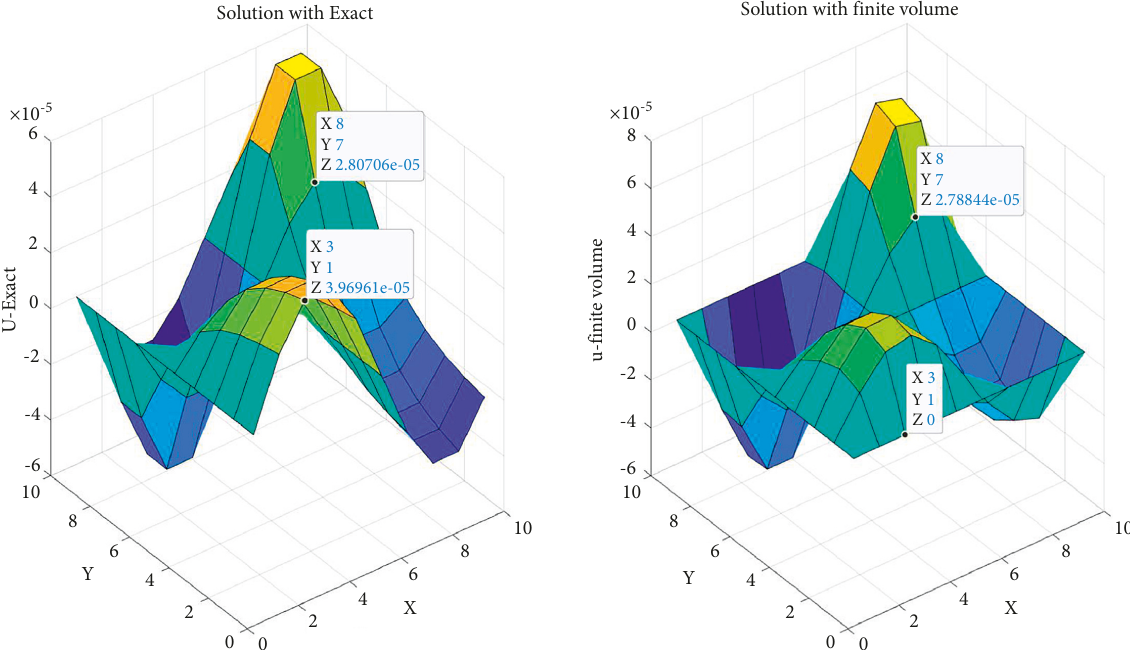
Figure 7: Analytical and approximate results of FVM at 15 × 15 grid size, time step � 0 . 0001, and h � 0 .